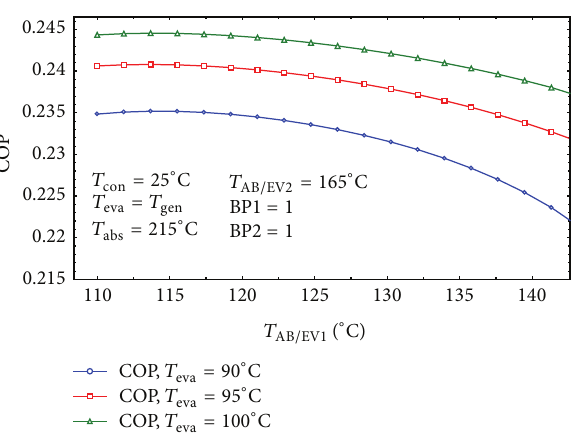
on the COP of the cycle for three con